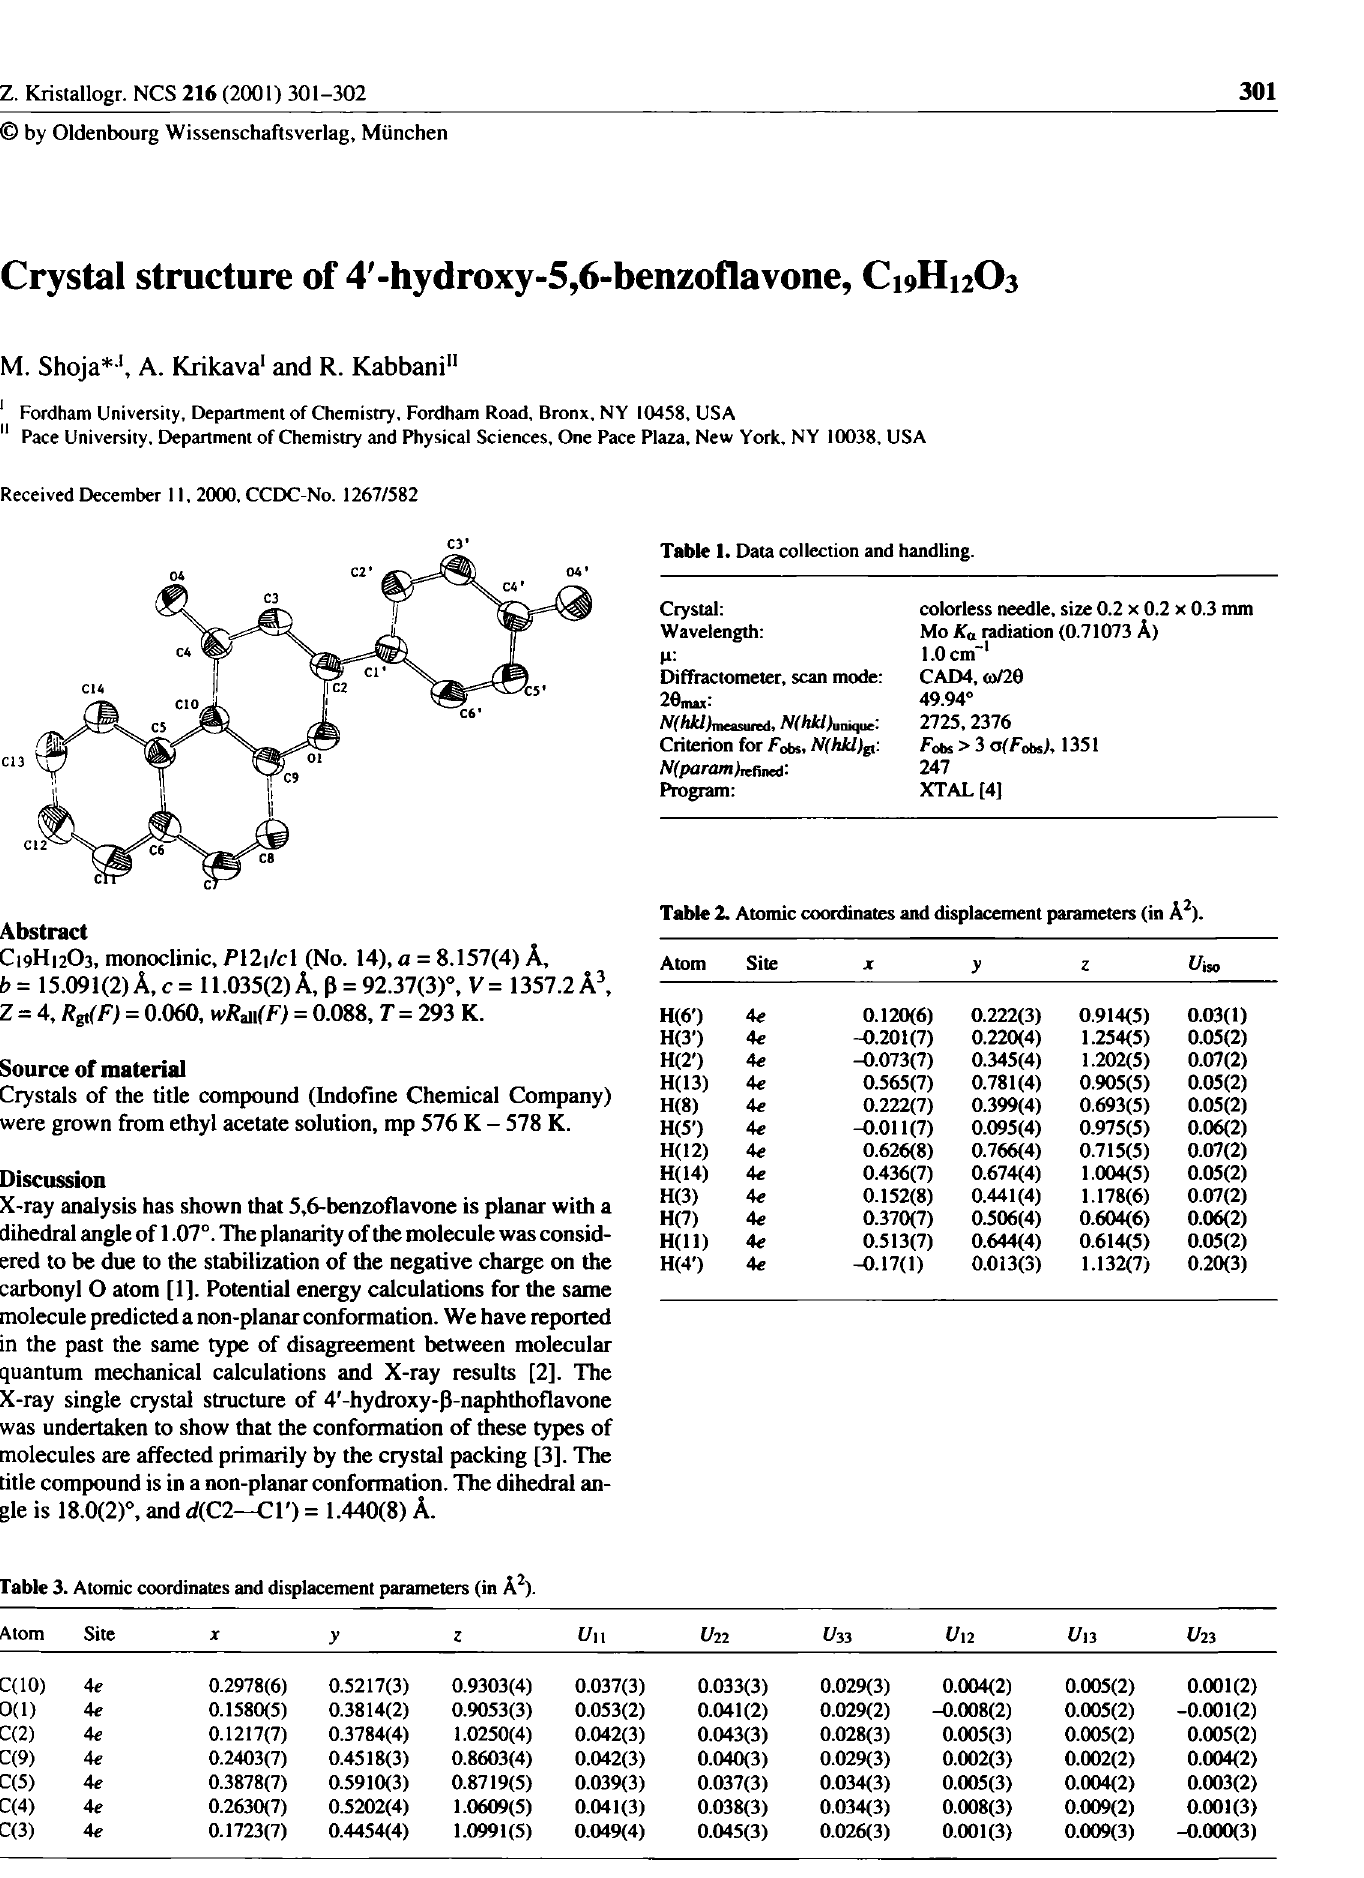
Table 3. Atomic coordinates and displacement parameters (in A 2